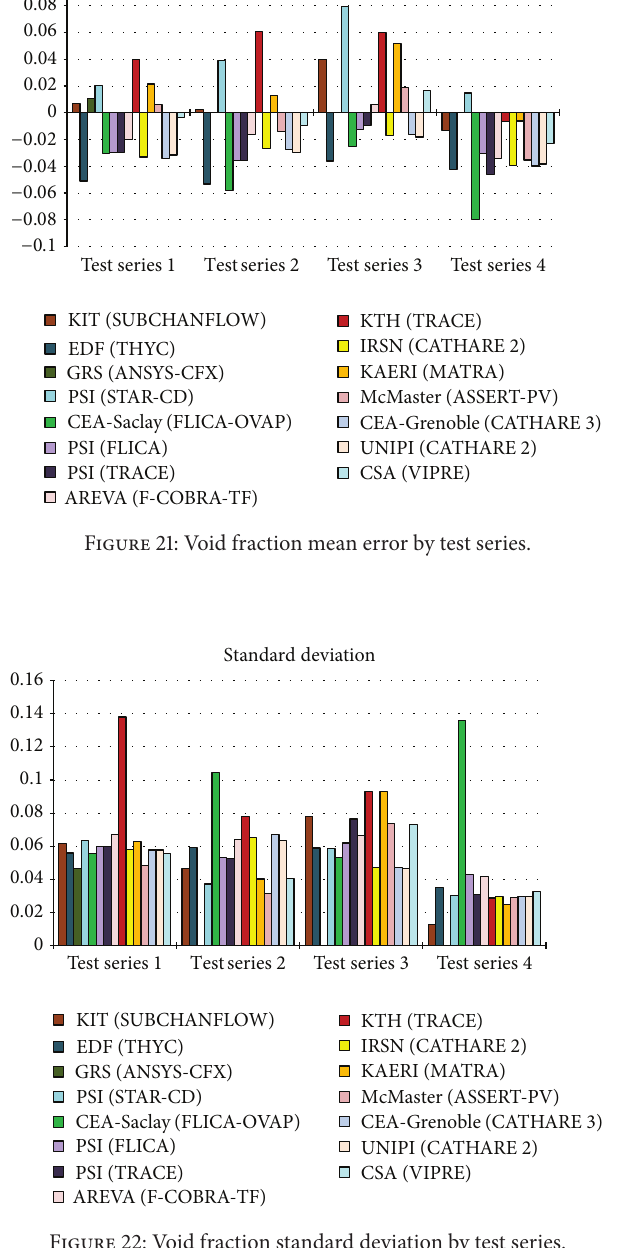
Figure 22: Void fraction standard deviation by test